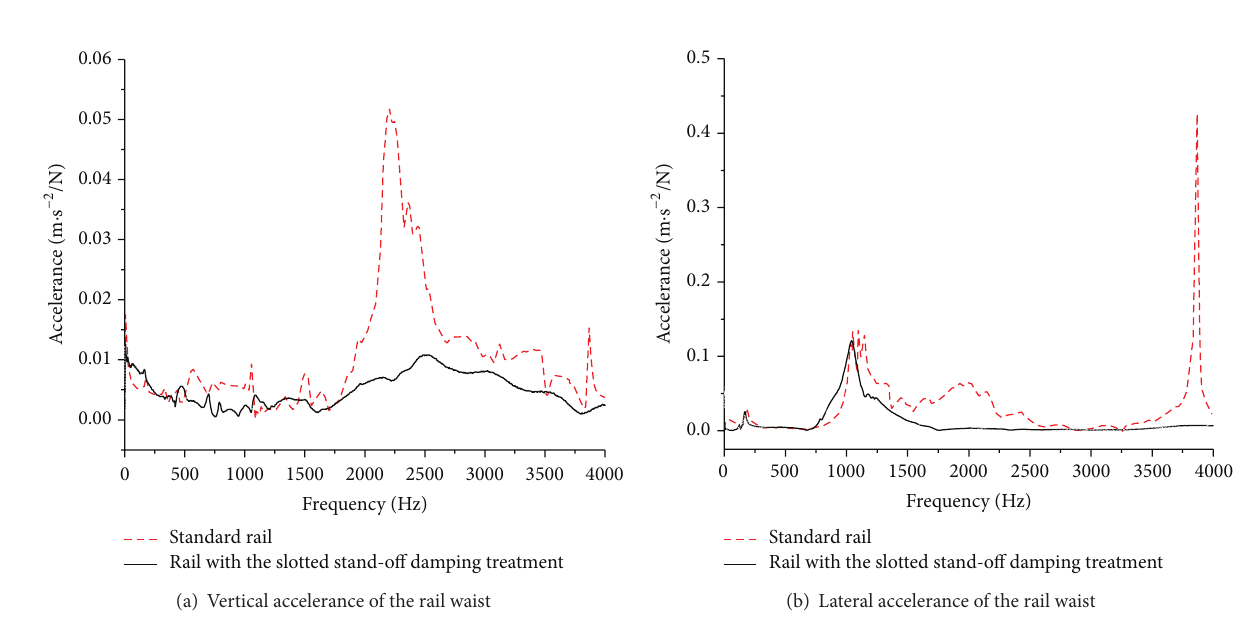
Figure 12: Accelerance of the rail head.